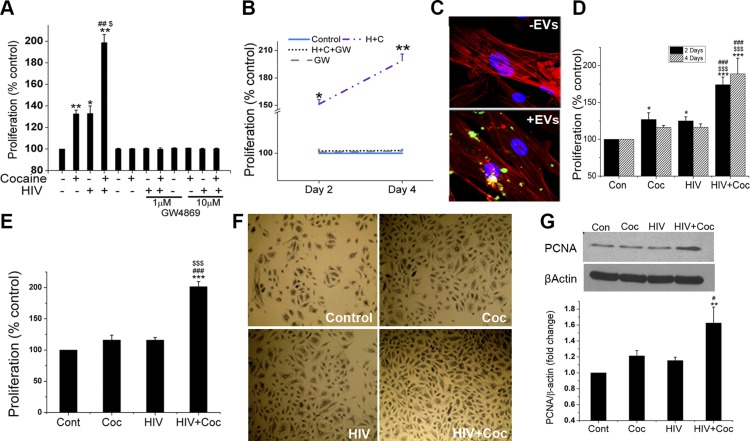
Increased SMC proliferation on uptake of H+C- or cocaine-treated MDM–derived EVs. A, B) Monomac-1–derived macrophages were treated with H+C in the presence or absence of GW4869 (1 or 10 μM). Supernatants collected were added on HPASMCs in 1:1 ratio with SMC medium followed by a cell proliferation assay after 2 and 4 d. C) Uptake of EVs by SMCs. EVs were labeled with fluorescent PKH67 dye (green) and added on HPASMCs (10 µg/24 well) for 2 h. Cells were later washed and fixed, followed by staining with phalloidin (red). D, E) Exosomes (2 μg) resuspended in PBS, isolated from untreated, cocaine (Coc) treated, HIV-1 infected and from both HIV-1-infected and cocaine-treated monomac-1 (D) or primary human monocyte (E) derived macrophages were added to 0.1% serum-starved HPASMCs overnight followed by replenishing the medium the next day. MTS cell proliferation assay was performed at 48 h after exosome treatment. F) Representative phase-contrast images of HPASMCs after MTS assay. G) Western blot analysis of HPASMC total cell extract after 48 h of EV treatment for proliferation marker, PCNA. Data are means ± sd from ≥3 independent experiments. *P < 0.05, **P < 0.01, ***P < 0.001 vs. control; #P < 0.05, ##P < 0.01, ###P < 0.001 vs. cocaine; $P < 0.05, $$$P < 0.001 vs. HIV.